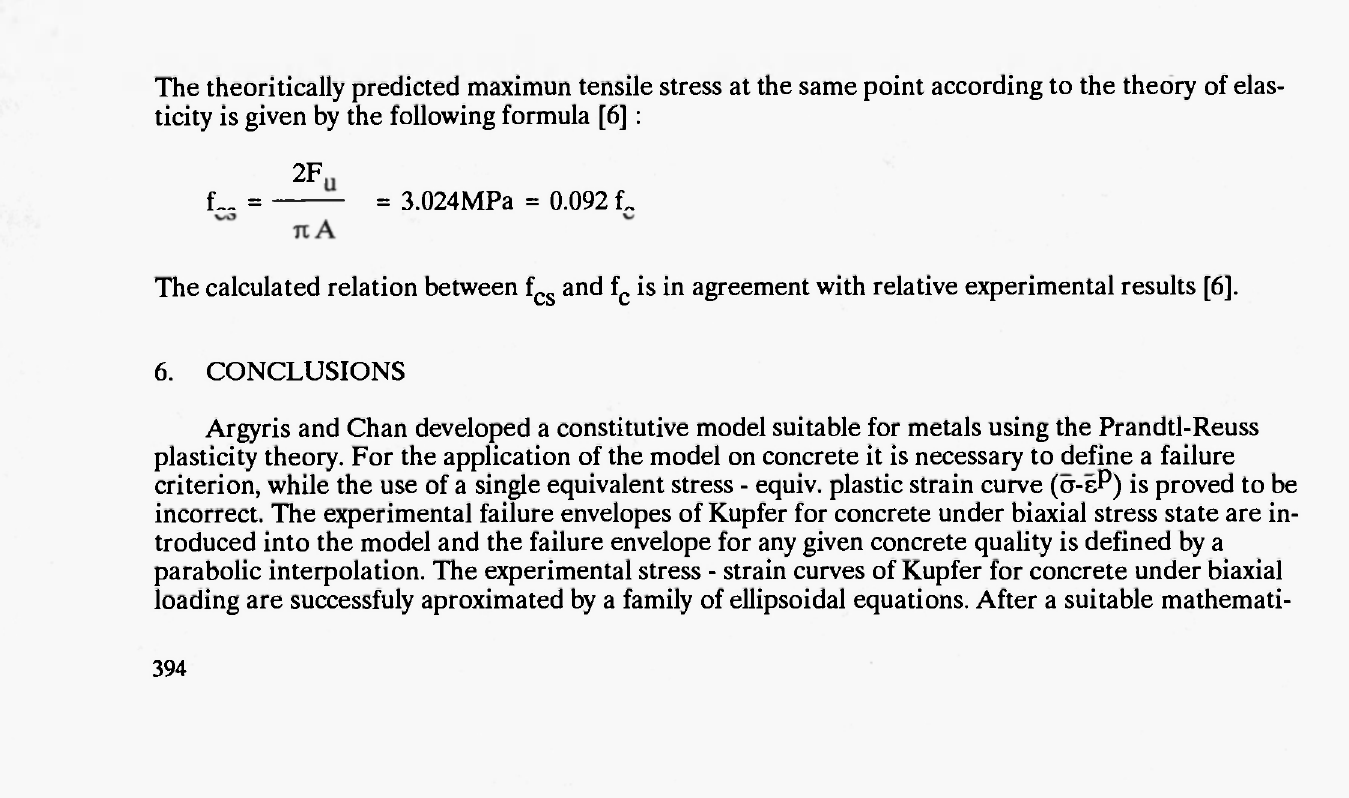
Figure 6. Analytical simulation with the RECOFIN pro- gram of a plain concrete cubic specimen under uniaxial compression between fixed plattens until